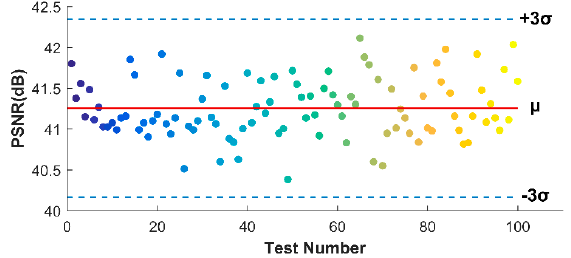
Figure 14. Distribution of 100 OMP runs based on 3 σ criterion of reliability theory in time domain, using 50 MHz SR experimental through-holes data when CR is 60%. Table 3. The standard deviation values ( σ ) of different SRs and CRs in time domain ( √ means the situation fits with 3 σ criterion, X means not).